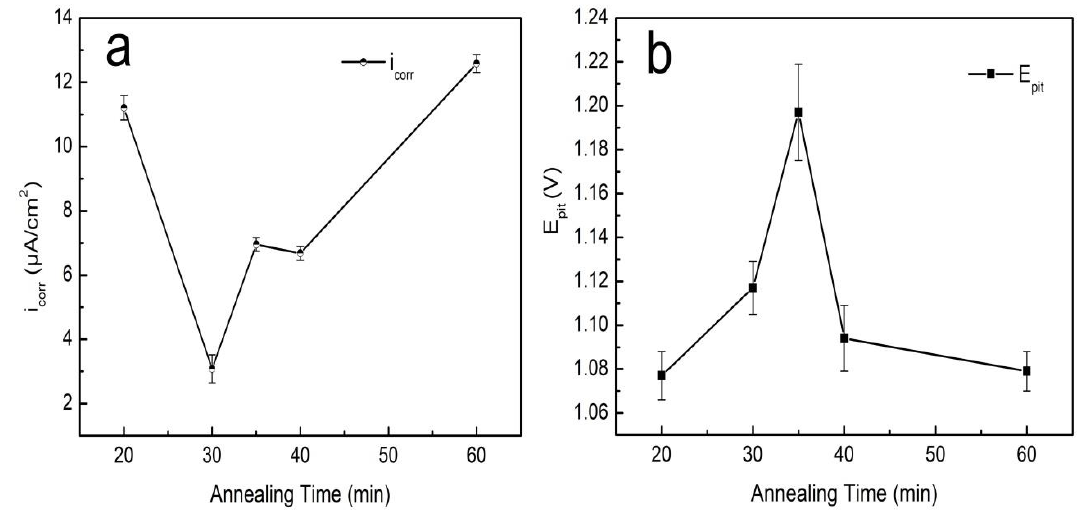
Figure 11. ( a ) Corrosion current density and ( b ) pitting potential of S32750 stainless steel at different annealing temperatures. Table 5. Corrosion current density and pitting potential values (average ± standard deviation) of S32750 stainless steel with different annealing times. The average and standard deviation values were obtained from 5 experiments.